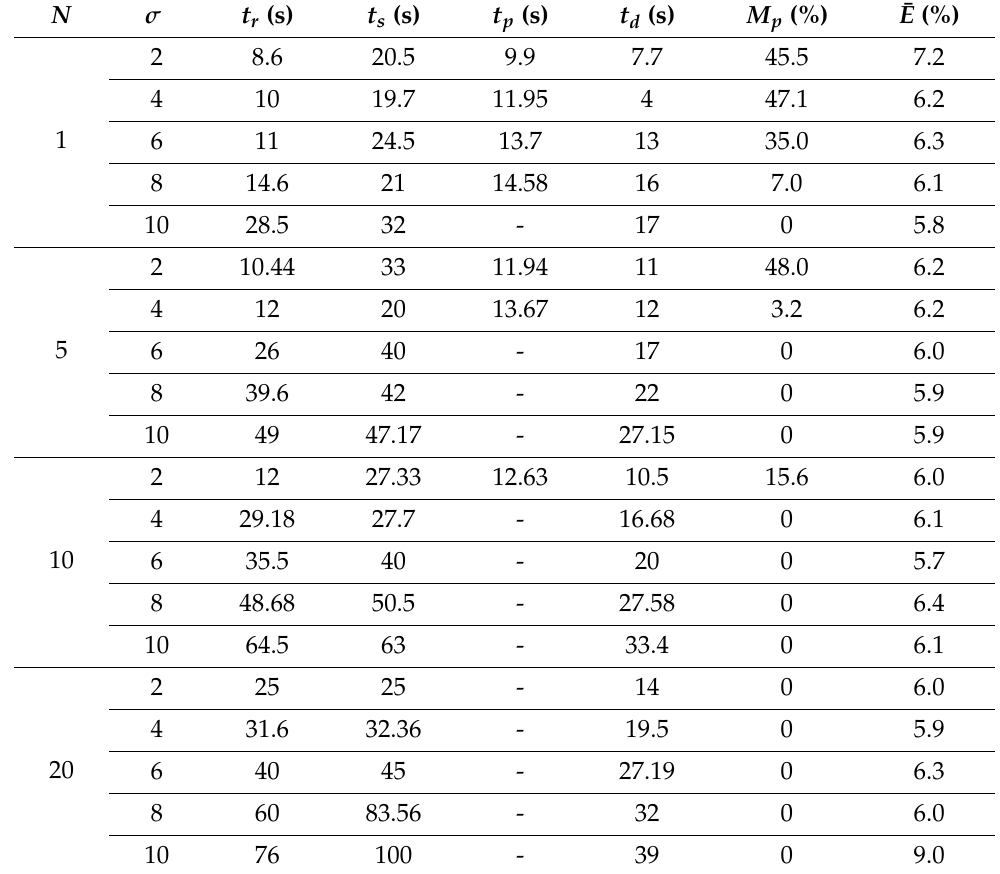
Table 1. Time response